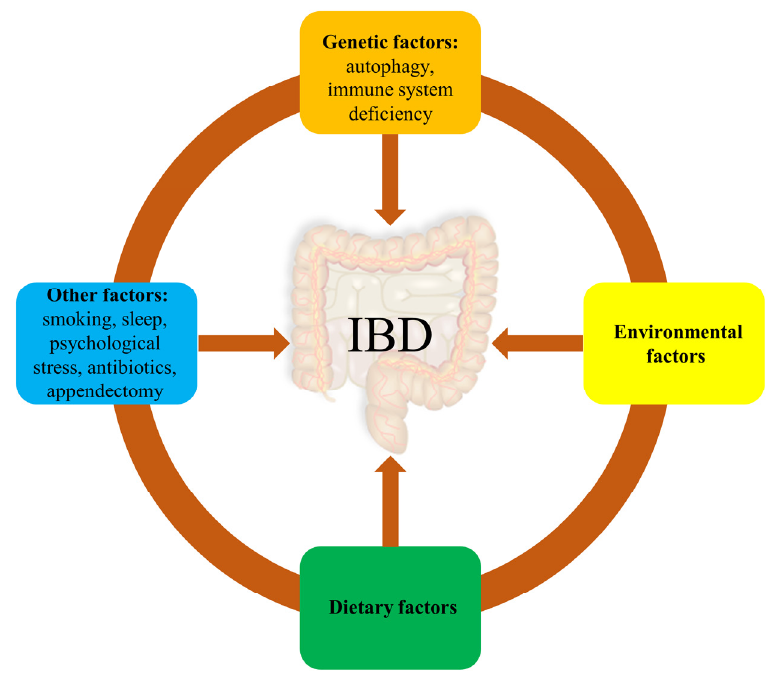
Figure 1. Causal factors of IBD.